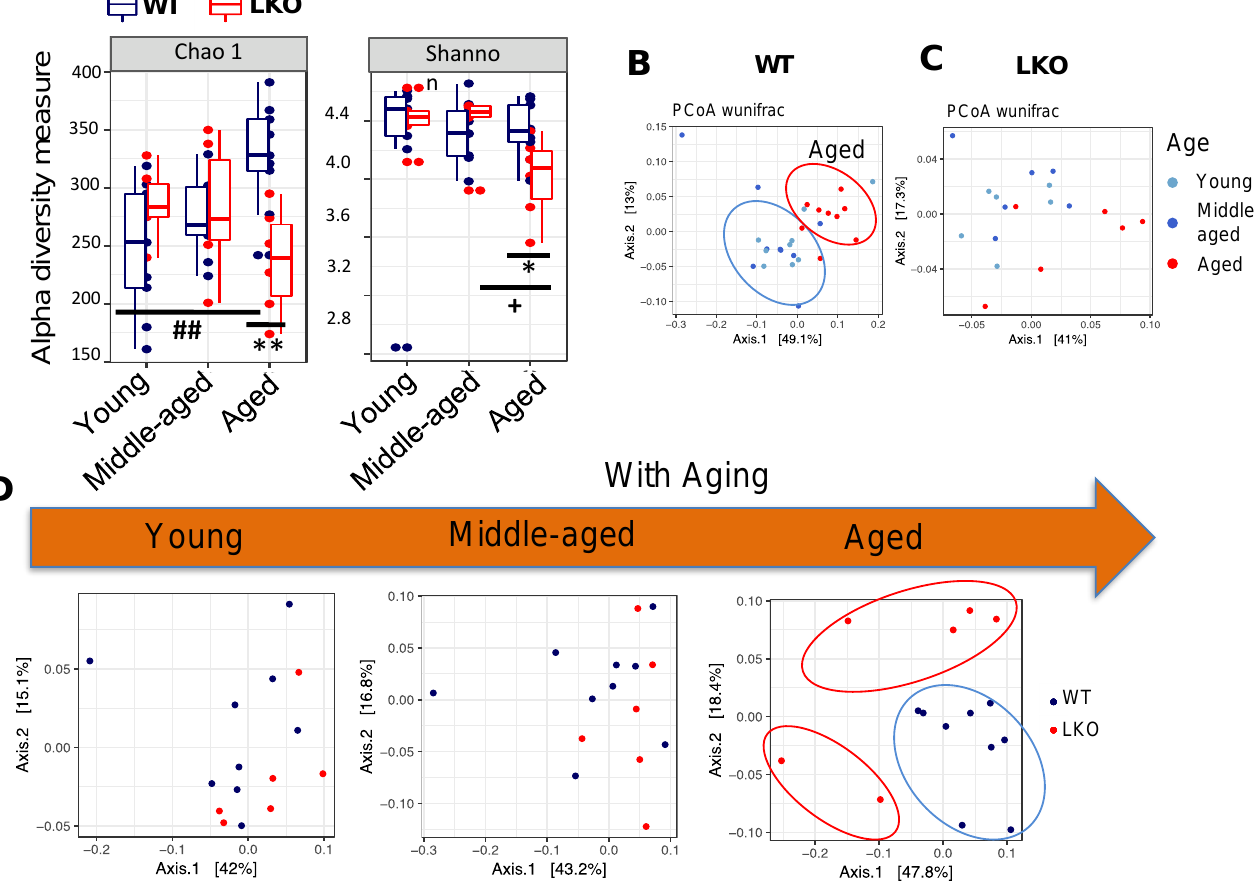
Figure 2. Age-associated reshaping of gut microbiota in LKO mice. Male WT mice (n = 9, 4 cages) and LKO mice (n = 6, 4 cages) were fed an RCD starting from weaning. Fecal samples were collected at the ages of 6 months (young), 12 months (middle-aged), and 18 months (old). ( A ) Alpha diversity metrics: Chao 1 and Shannon are shown to demonstrate the richness and evenness of gut microbiota communities. * p < 0.05, ** p < 0.01 versus WT mice. ## p < 0.01 versus young WT mice. + p < 0.05 versus middle-aged LKO mice. ( B – D ) Beta diversity (weighted unifrac) indicates the dissimilarity between WT ( B ) and LKO ( C ) mice at all three stages of age and the genotypic difference at each age stage ( D